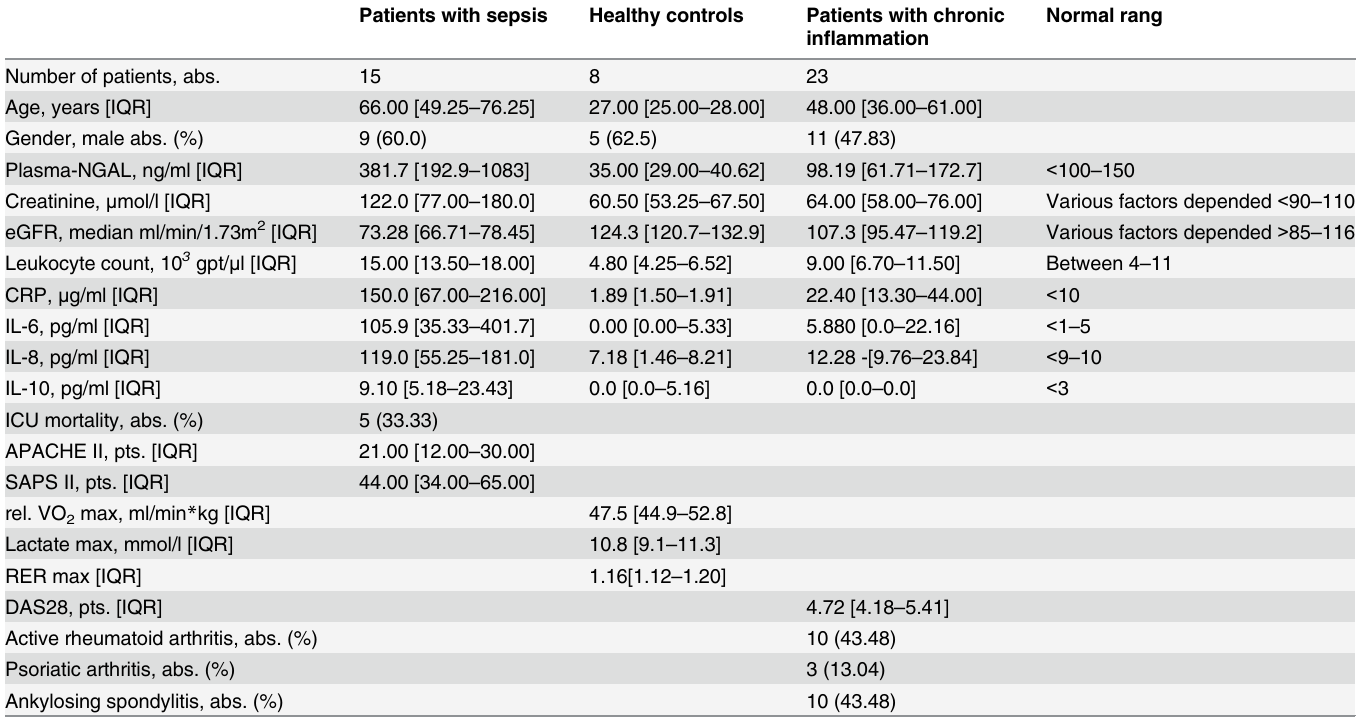
Table 1. Characteristics of patients with sepsis, healthy controls and rheumatic disease. Patients with sepsis Healthy controls Patients with chronic